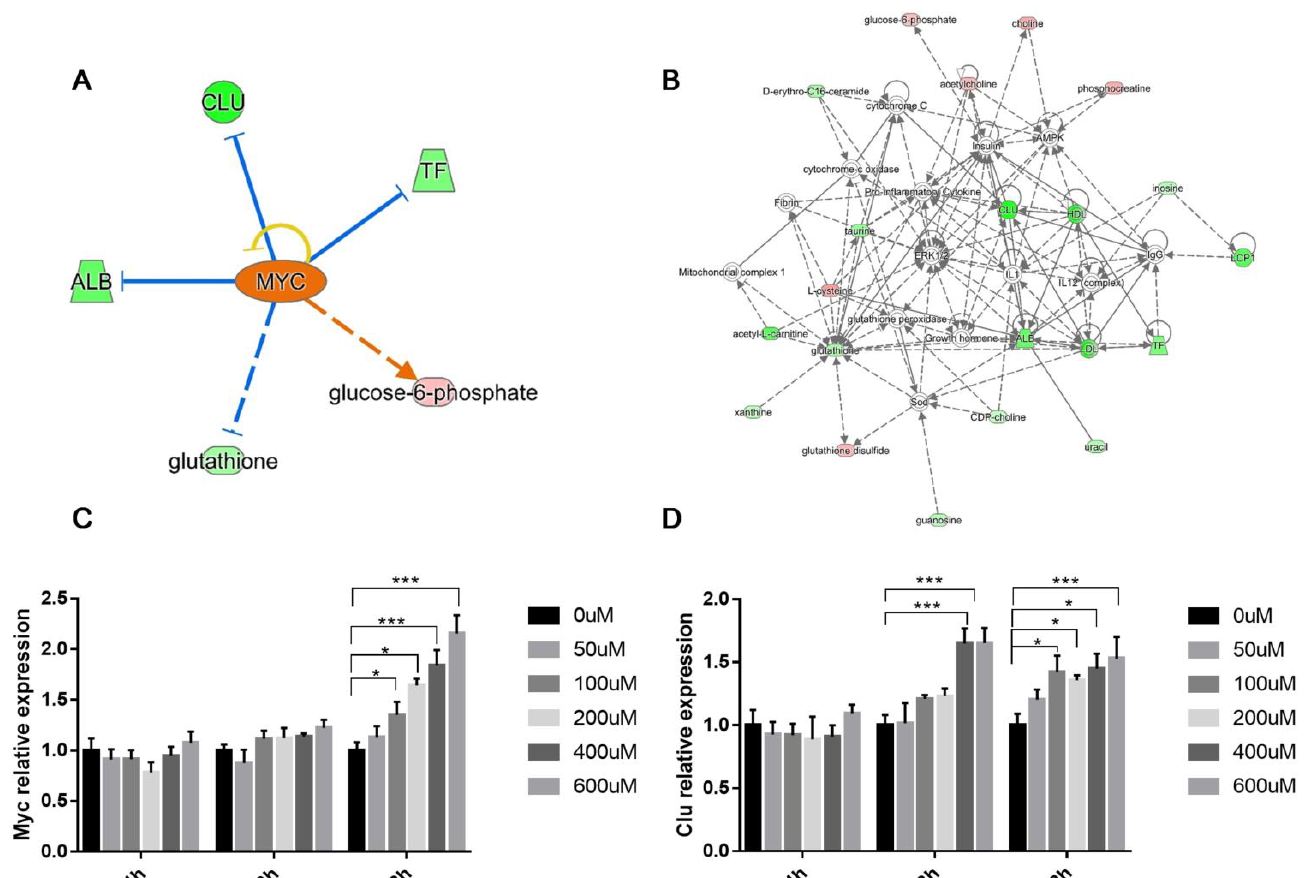
Figure 7. MYC-activation involved in 2,2′,4,4′-tetrabromodiphenyl ether (BDE-47)-induced male reproductive toxicity. ( A ) MYC was activated via Ingenuity Pathways Analysis (IPA). ( B ) Top-ranked gene network reconstructed from the genes associated with BDE-47-induced toxicity. ( C ) Clu and ( D ) MYC expression levels in the dose response and time course. β-actin was used as an equal loading control. Data are presented as mean ± SD of three independent experiments (n = 3). * p < 0.05, *** p < 0.01 significant differences compared to con- trols.